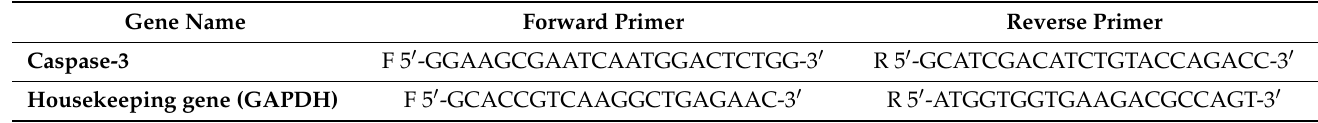
Table 7. Oligonucleotide primer pairs used for quantitative real-time polymerase chain reaction (RT-qPCR)